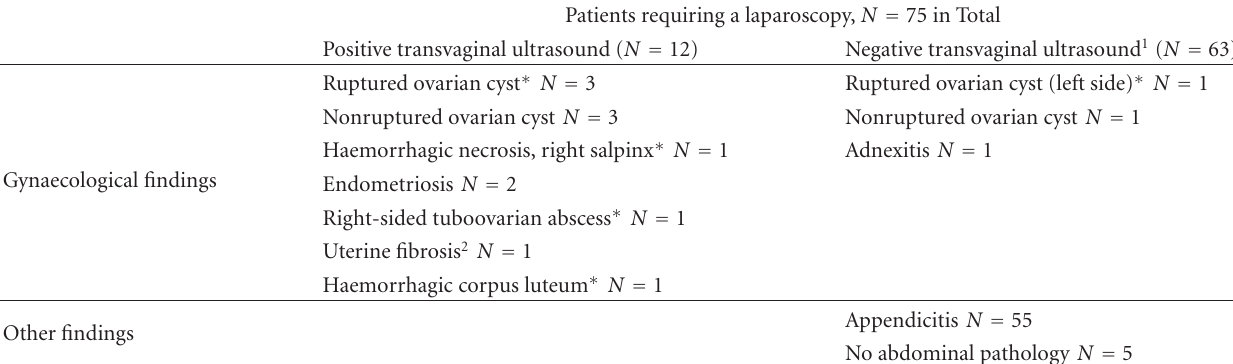
Table 2: Postoperative diagnoses of patients requiring a diagnostic laparoscopy. Patients requiring a laparoscopy, N = 75 in